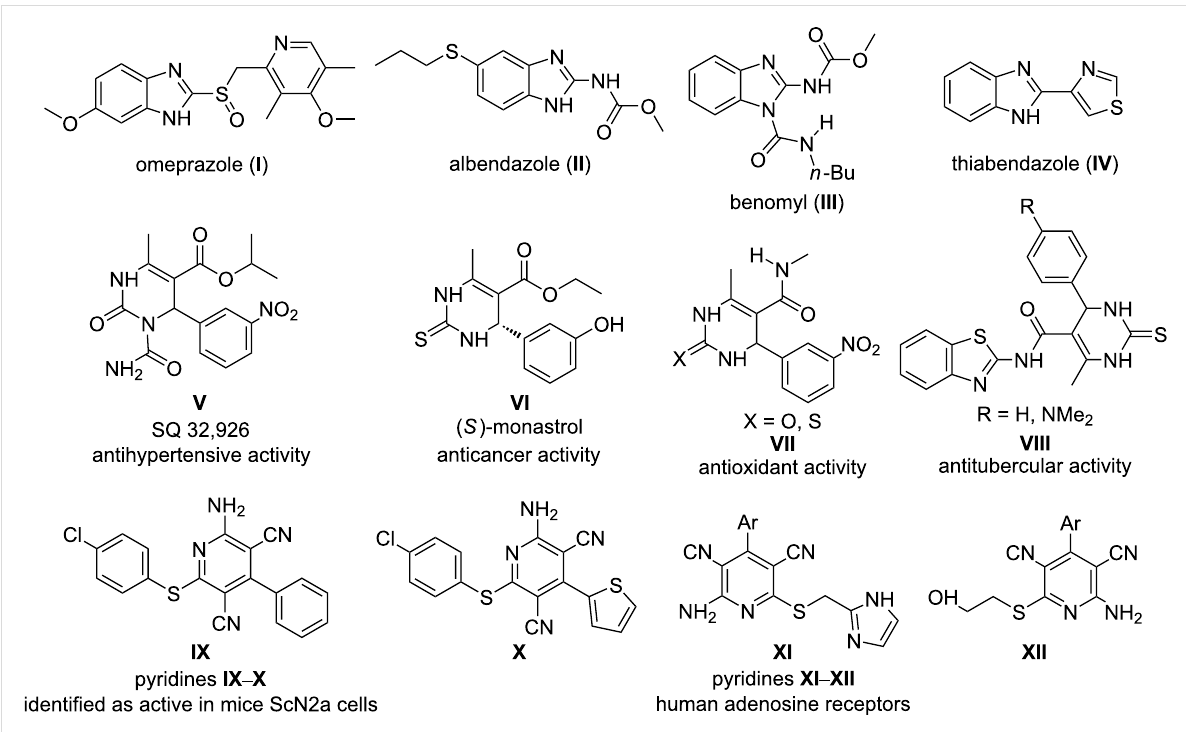
Figure 1: The benzimidazoles I – IV , dihydropyrimidinones/-thiones V – VIII , and 2-amino-4-aryl-3,5-dicarbonitrile-6-sulfanylpyridines IX – XII as medici- nally privileged structures.